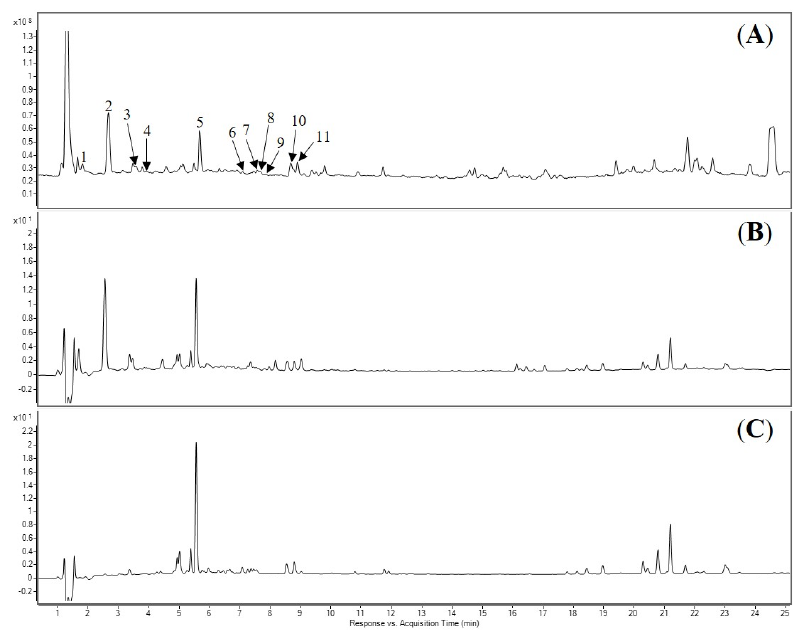
Figure 1. Chemical structures of isolated and/or standard compounds from AE.